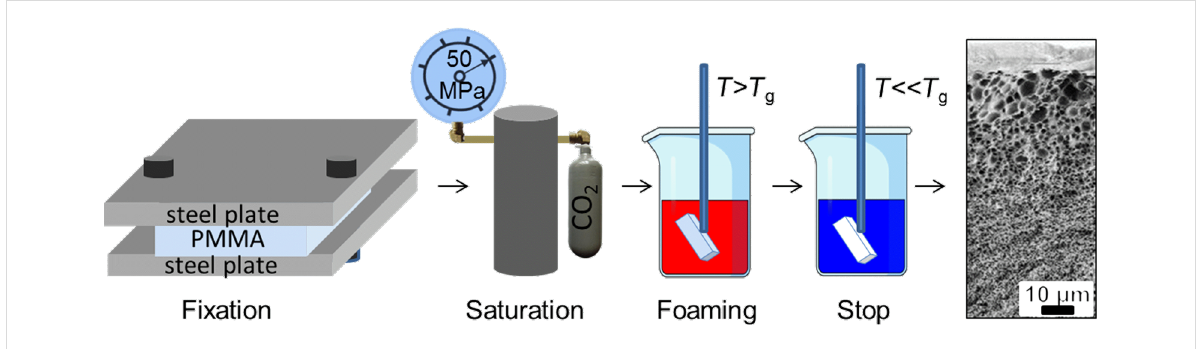
Figure 1: A schematic of the foaming process showing the critical steps to obtain a sample with a controlled gradient of pore size. The pore-size gradient is achieved through an inhomogeneous CO 2 concentration in the sample at the saturation step and a temperature gradient during the pore growth. An SEM image of a cross section of a generic sample is shown. The average pore sizes range from 5 μ m to 200 nm over the cross